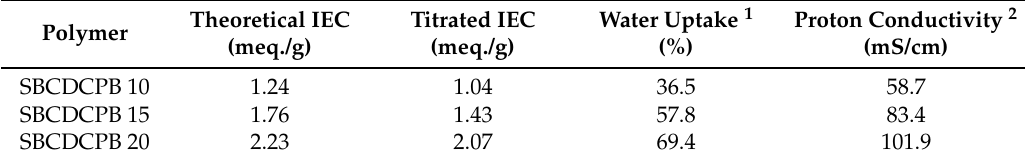
Table 1. Properties of polyphenylene membranes.